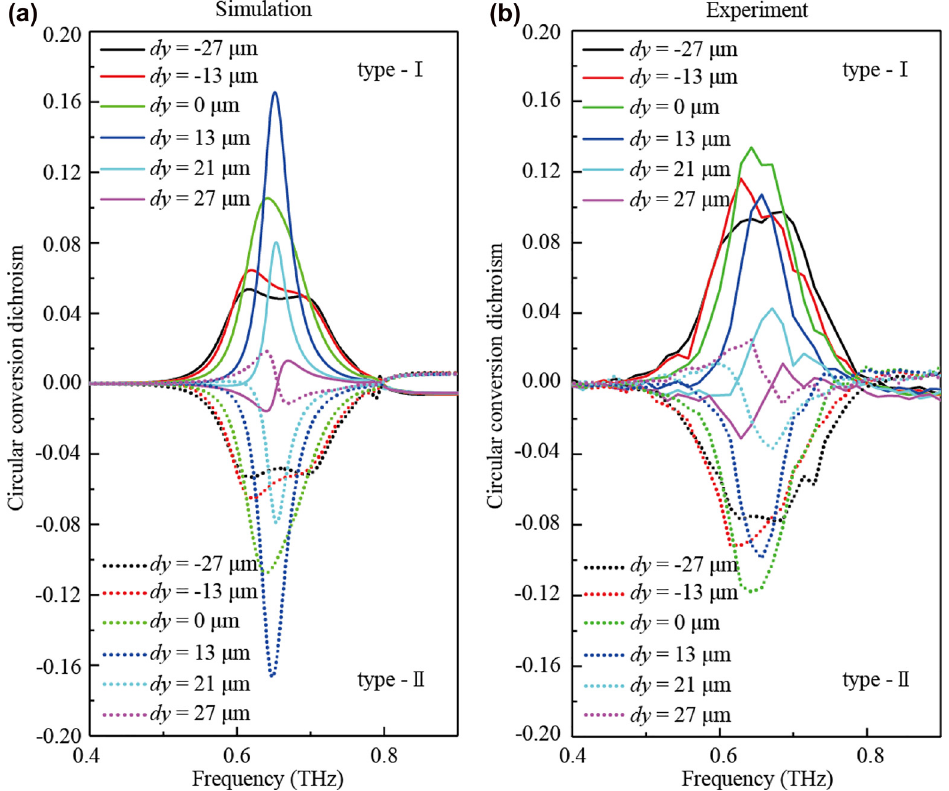
Figure 4: CCD of the chiral metasurfaces. (a) Simulated and (b) experimental CCD spectra of the metasurfaces type-I (solid lines) and type-II (dashed lines) with varying dy